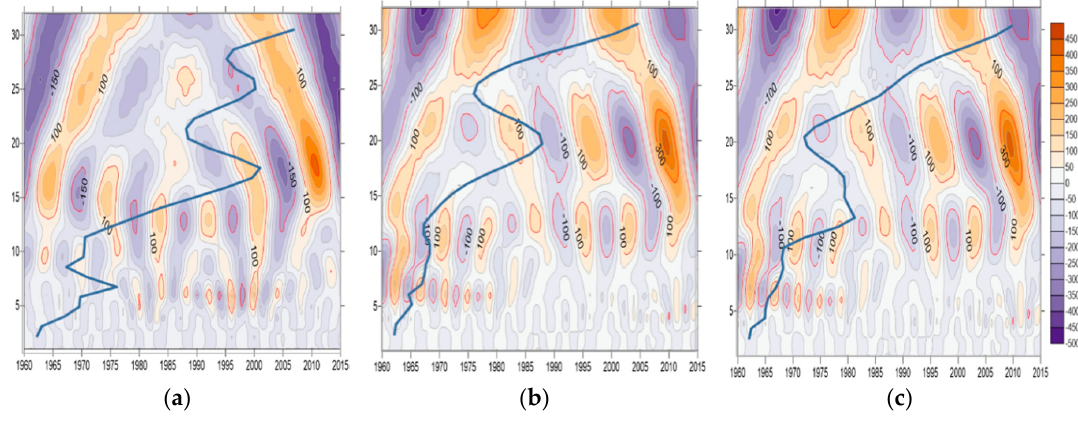
Figure 7. The real part of Morlet wavelet transform coefficient and the wavelet variances of rainfall at representative weather stations in the Mun River basin: ( a ) at Phi Mai Barrage station; ( b ) at Mun River station; and ( c ) at Regional R.I.D. station